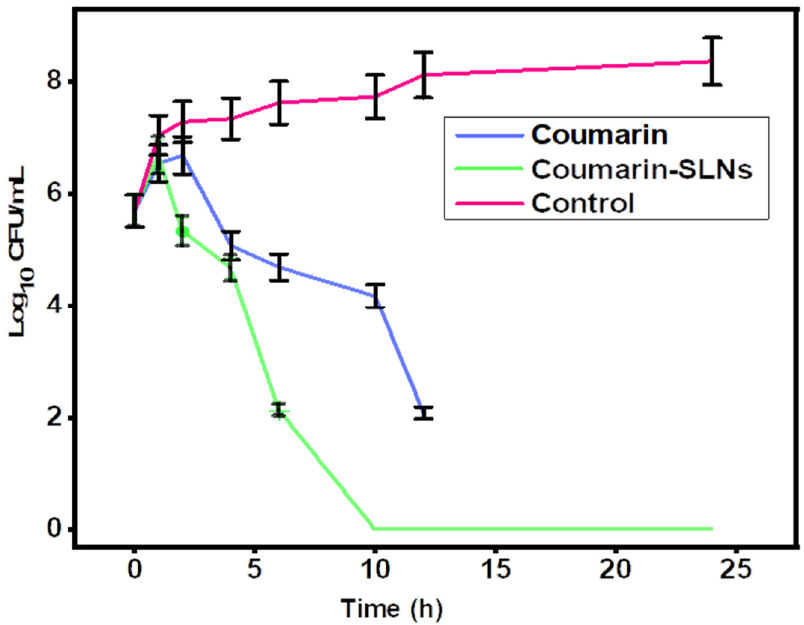
Figure 4. Comparative bactericidal time-kill kinetics of control, coumarin, and coumarin-loaded SLN treatment against